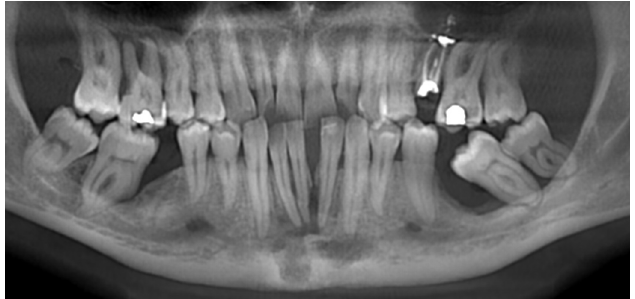
Fig. 4. Ten-month follow-up, panoramic radiograph showing reduc- tion of bone loss after chemotherapy (compare to Fig. 2).